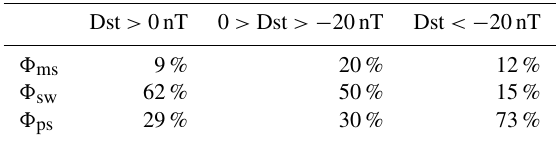
Table 2. Estimated fate of oxygen ions expressed as percentages of outflow flux. (cid:56) represents the flux, and subscripts ms, sw and ps represent magnetosheath, solar wind and plasma sheet, respec- tively. σ par represents the standard deviation of the parallel initial velocities.